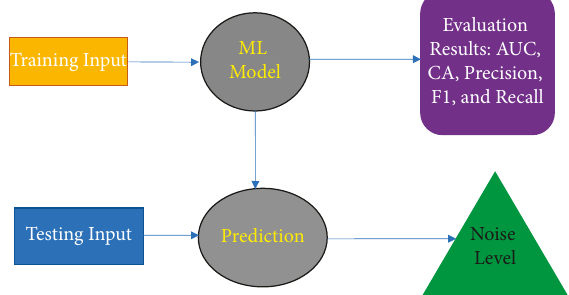
Figure 8: Flowchart of prediction model for estimating the noise